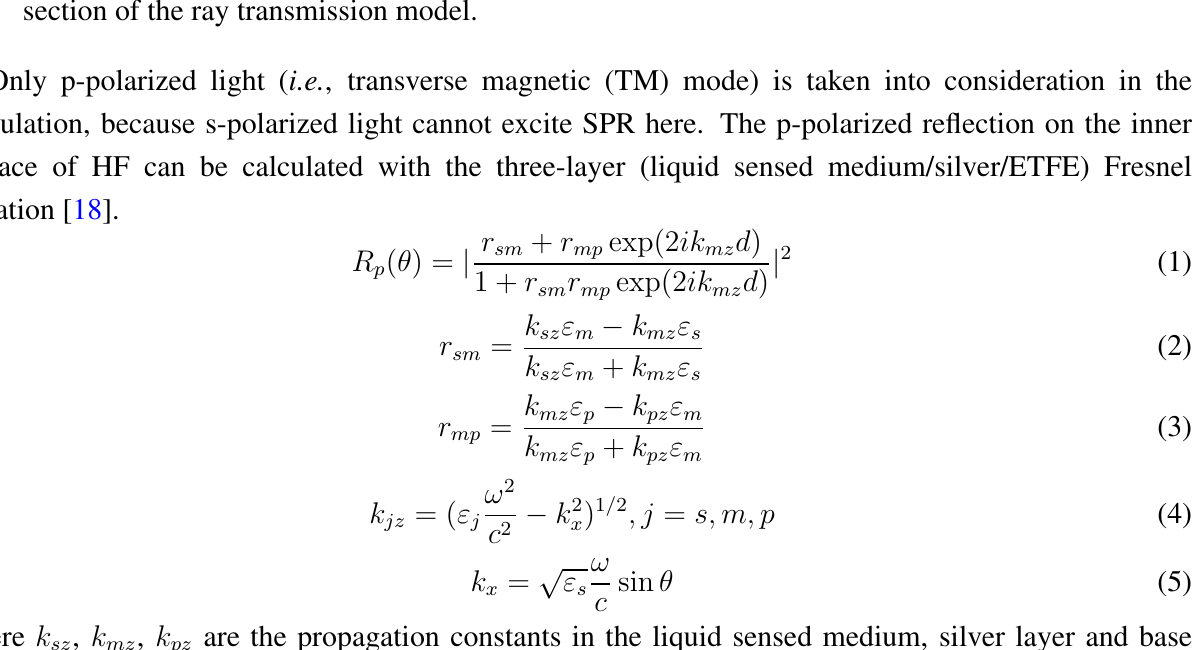
Figure 1. Schematic diagram of ethylene the tetra-fluoro-ethylene (ETFE) hollow fiber surface plasmon resonance sensor (HF-SPRS): ( a ) structure of the sensor; ( b ) lengthwise section of the ray transmission